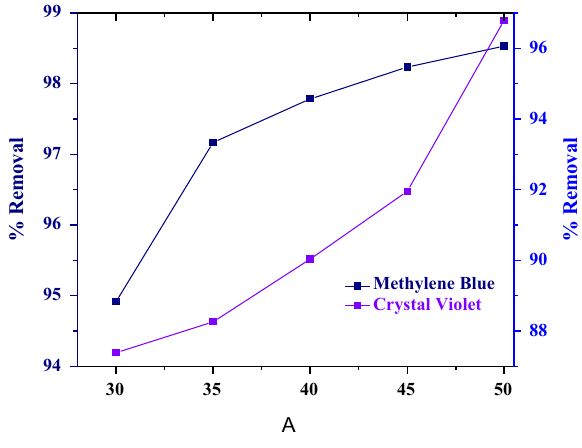
Fig. 8 Effect of temperature on the removal of CV and MB by